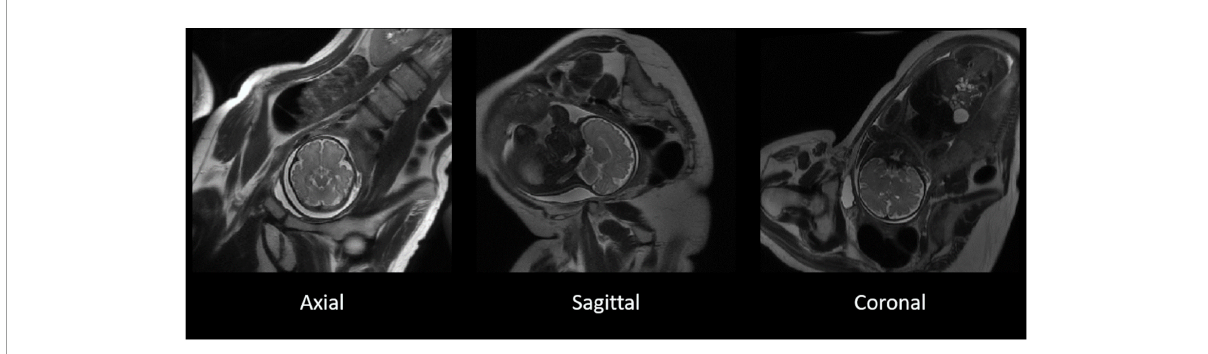
FIGURE1 The original T2-weighted acquisition of a fetal MR image in axial, sagittal, and coronal planes. T2-weighted images acquired separately in three separate image planes in the axial (left) , sagittal (middle) , and coronal (right) in a representative participant. The three image planes were subsequently used for the reconstruction of 3D